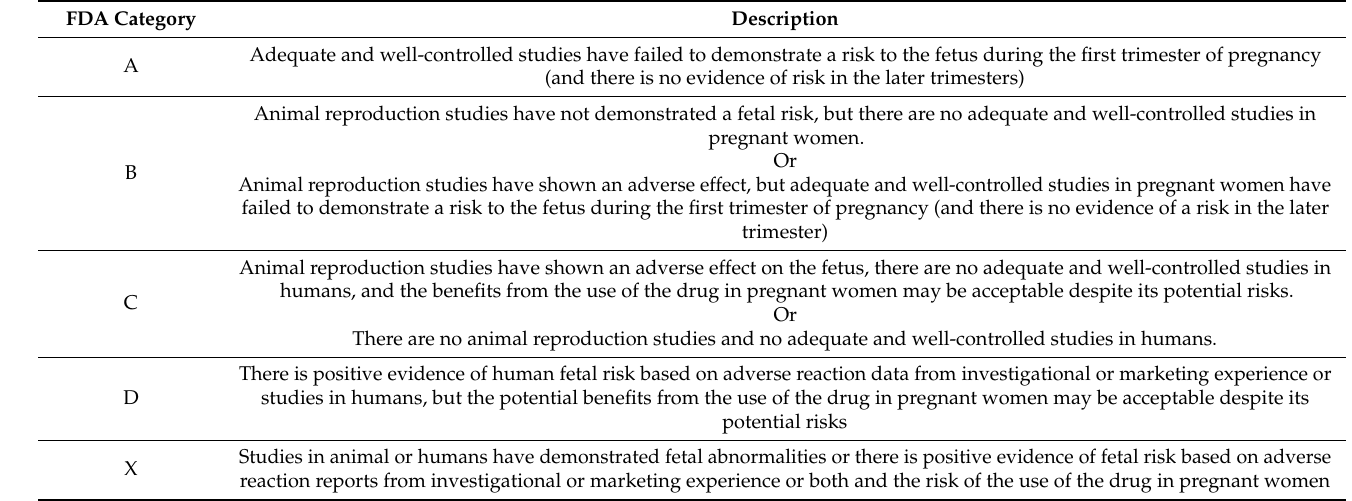
Table 1. US Food and Drug Administration categories for drug safety during